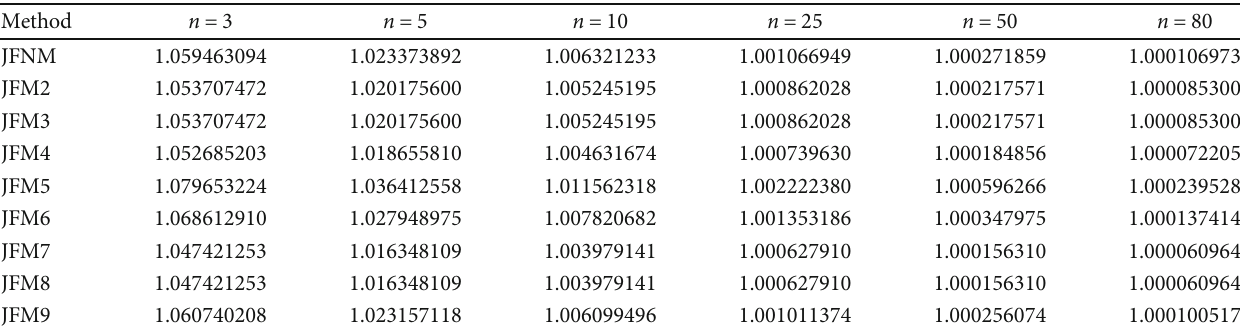
Table 26: Values of EI for the methods in the second category to solve Test Problem 1, and n = 3, 5, 10,25,50,80 .